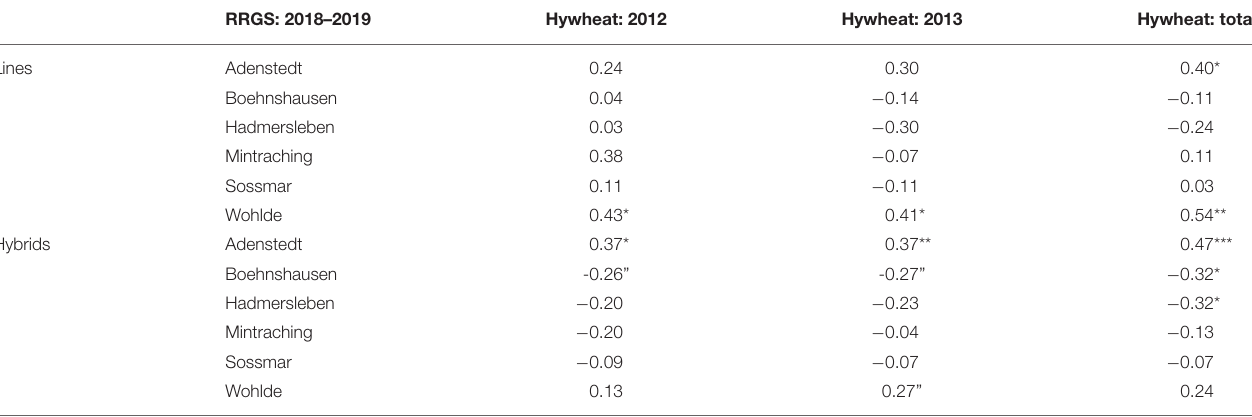
TABLE 3 | Correlations of phenotypic data from single environments of the RRGS experiments (2018–2019) with phenotypic data from HYWHEAT experiments and with single years of the HYWHEAT experiment.